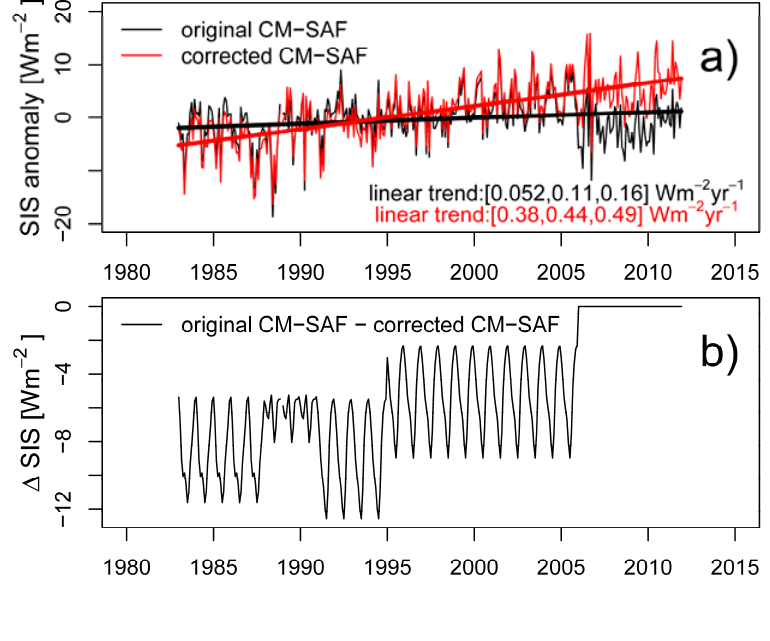
Figure 10. ( a ) Monthly mean SIS anomaly series of the original (black) and the corrected (red) CM SAF dataset, and ( b ) mean monthly difference series between the original and the corrected CM SAF anomalies over the European region (the area shown in Figure 2) for the period 1983–2007. The time series are expressed as anomalies to the 1983–2007 mean, and the linear trends are indicated (thick